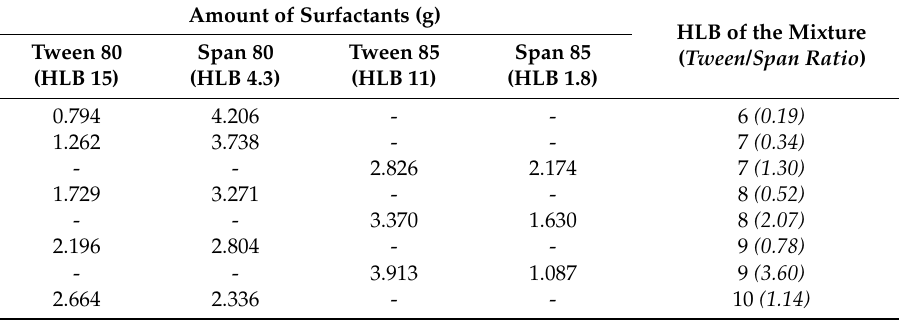
Table 3. Mixtures on non-ionic surfactants used for obtaining the chosen HLB values; design of the study used for the preparation of hemp seed oil emulsions. Amounts of surfactants are given for their 5 wt % contents in 100 g of